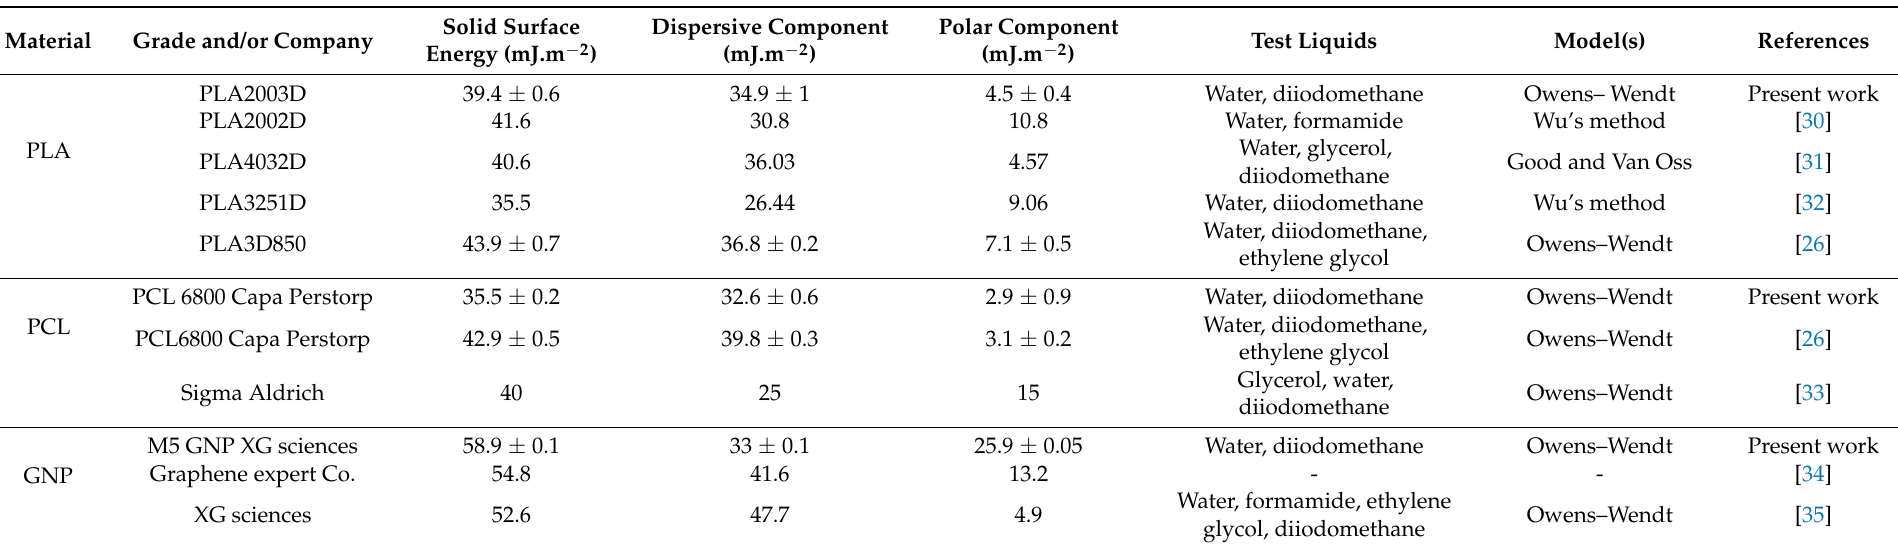
Table 2. The solid surface energy, its dispersive and polar components, the test liquids, and the models used for solid surface energy calculations of the PLA, PCL, and GNP (our work and works from the previous